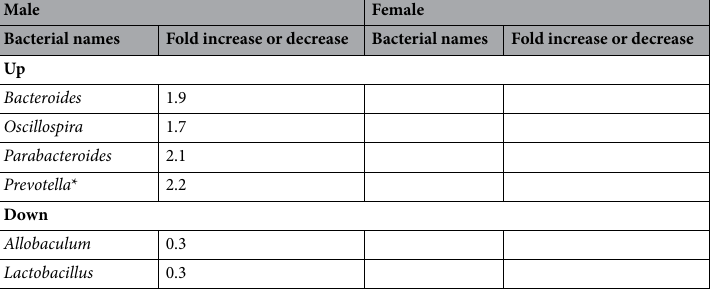
Table 2. Perturbed bacteria at the genus level. *k_Bacteria; p_Bacteroidetes; c_Bacteroidia; o_Bacteroidales; f_Paraprevotellaceae; g_Prevotella.